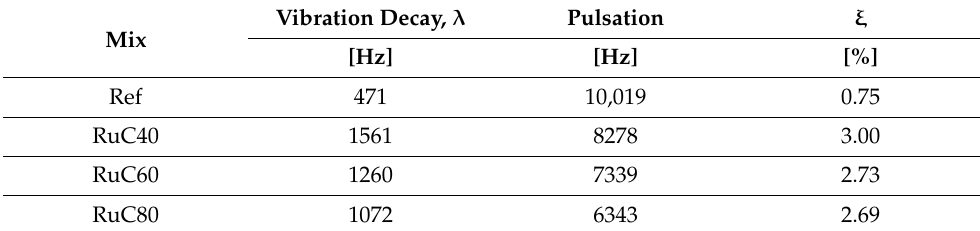
Table 3. Material